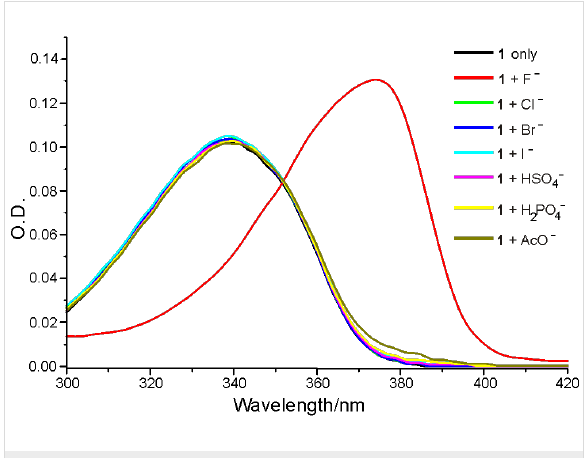
Figure 2: The absorption spectra of receptor 1 (5 μ M) in the absence or presence of a 50 equiv of F − , Cl − , Br − , I − , HSO 4 − , H 2 PO 4 − and AcO − anions in CH 3 CN.